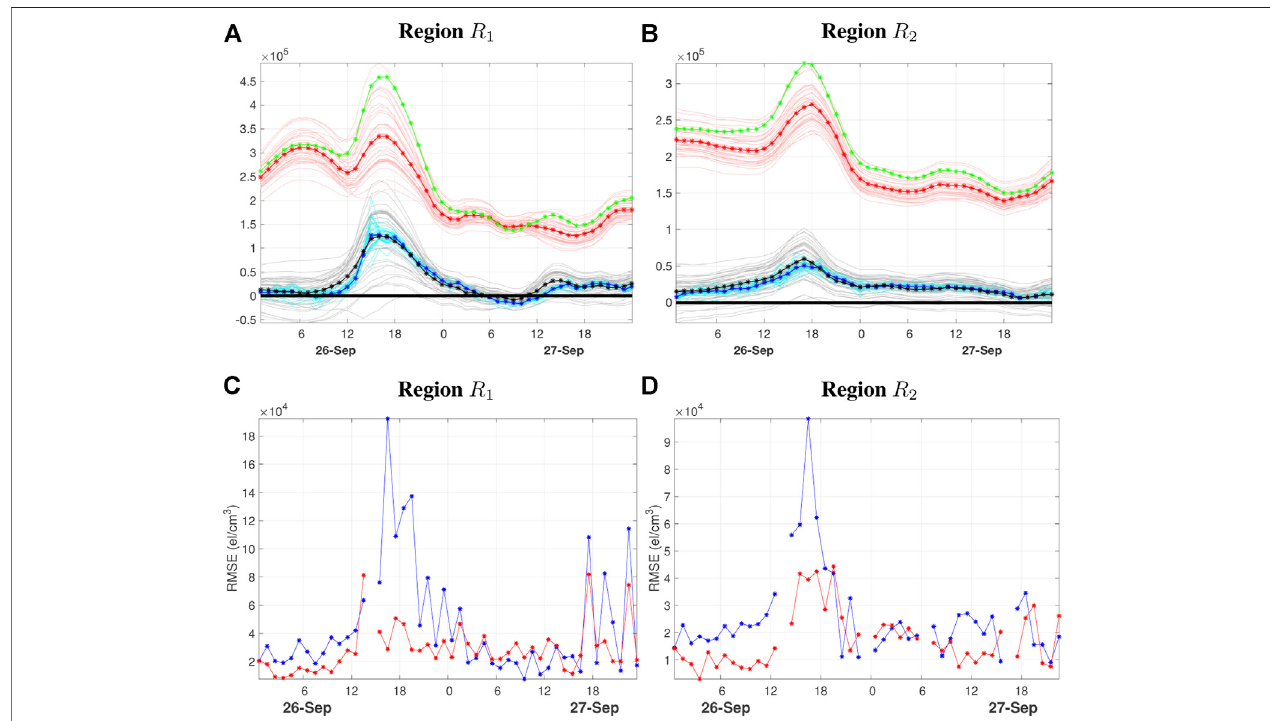
FIGURE6|(A,B) Timeseriesofbiascorrectionparametersaveragedoverregions R 1 and R 2 ,respectively.Thebiascorrectionvaluesinthis fi gurearecalculatedin the same manner as Figures 3A,B , but in the case where the bias evolution operator described in Section 5 is used. (C,D) Time series of the root mean squared error (RMSE) of 1 h forecasted electron density predictions, in el / cm 3 in regions R 1 and R 2 , respectively. The RMSE values in this fi gure are calculated in the same manner as Figures 4A,B , but in the case where the bias evolution operator described in Section 6 is used.